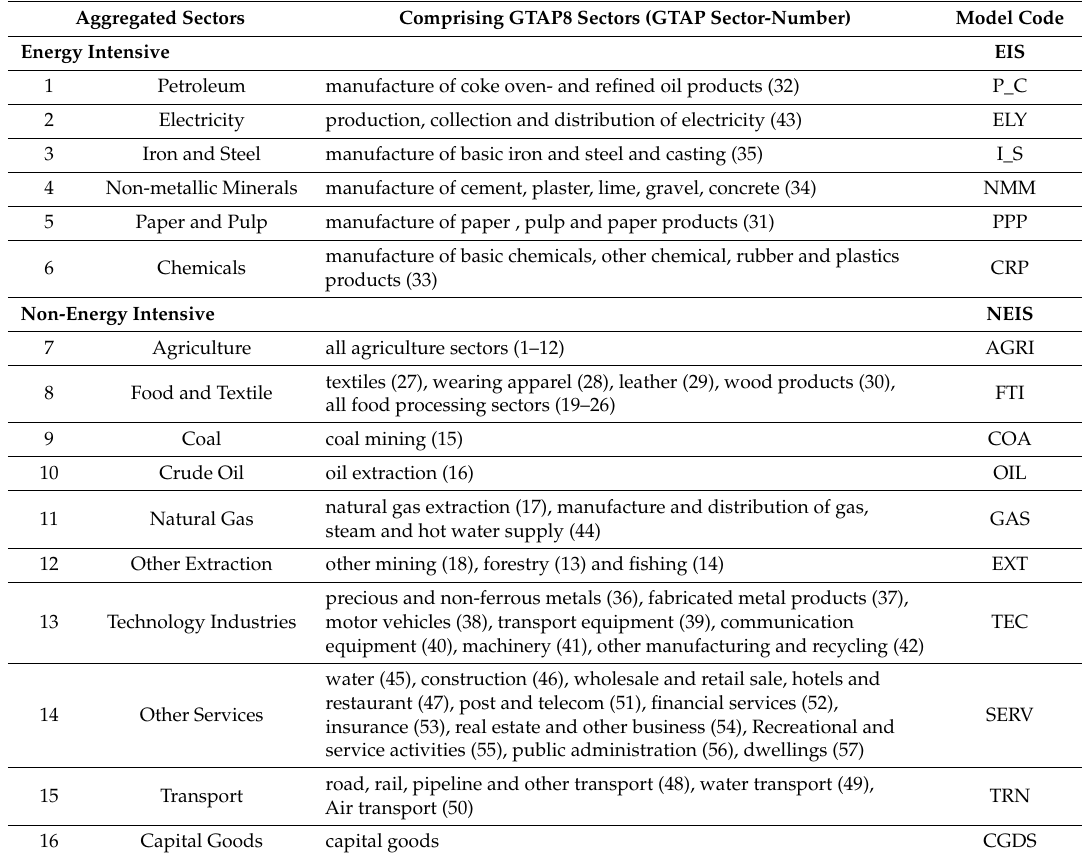
Table 2. Sectoral dimension of the CGE model. Source: GTAP8 [42].